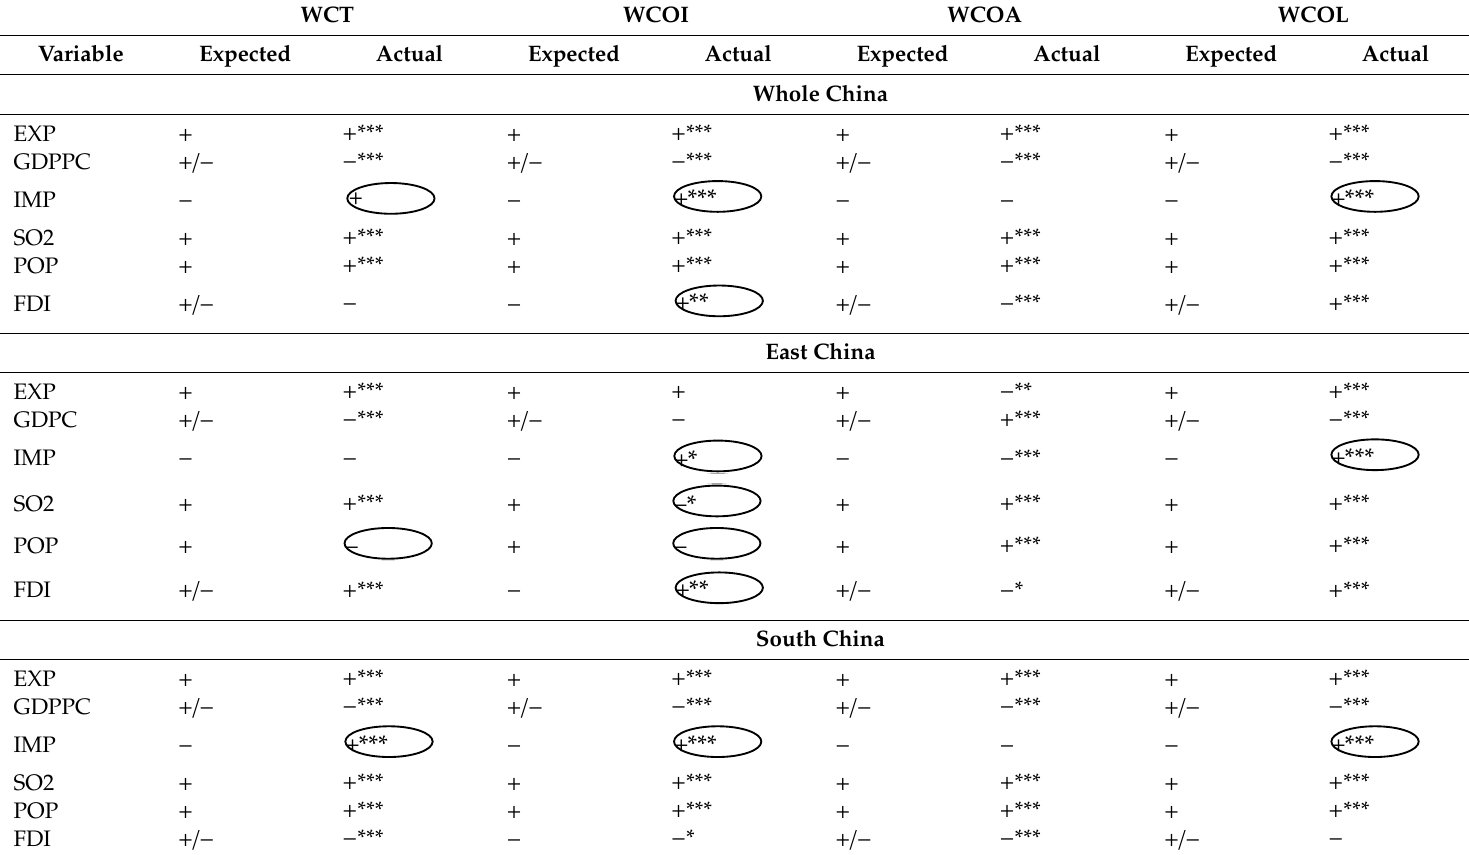
Table 9. FMOLS estimates and the sign comparison—expected versus actual.